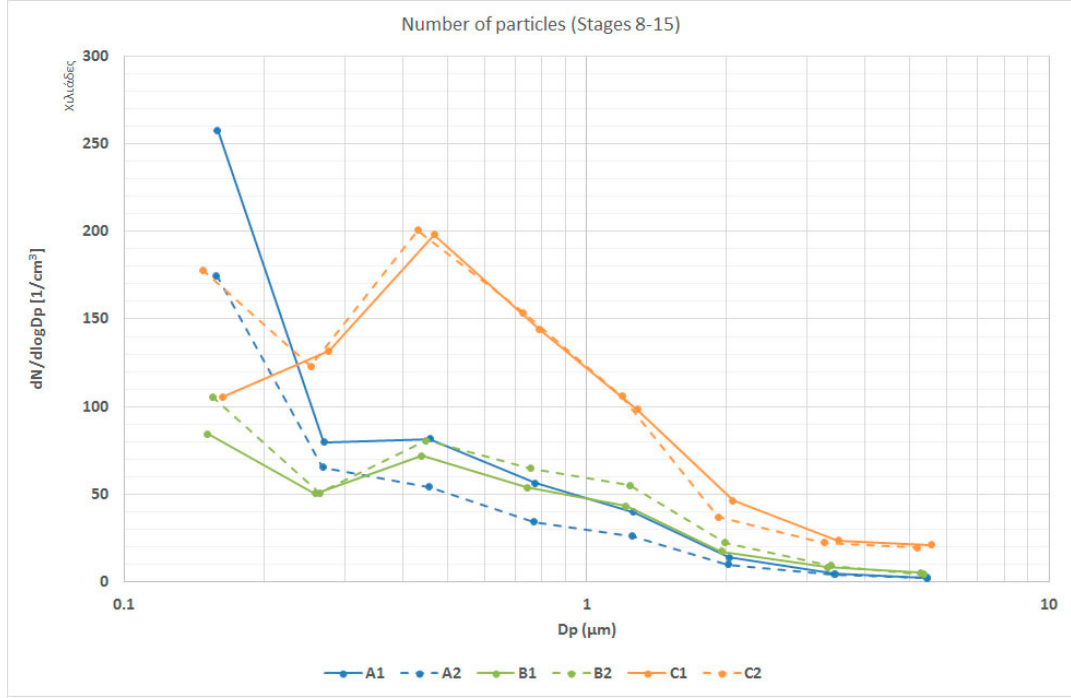
/ cm 3 ) for sampling stages 8 to Figure 4. Number of particles emitted (1/cm 3 ) for sampling stages 8 to 15. Figure 4. Number of particles emitted (1 Figure 4. Number of particles emitted (1/cm 3 ) for sampling stages 8 to 15.